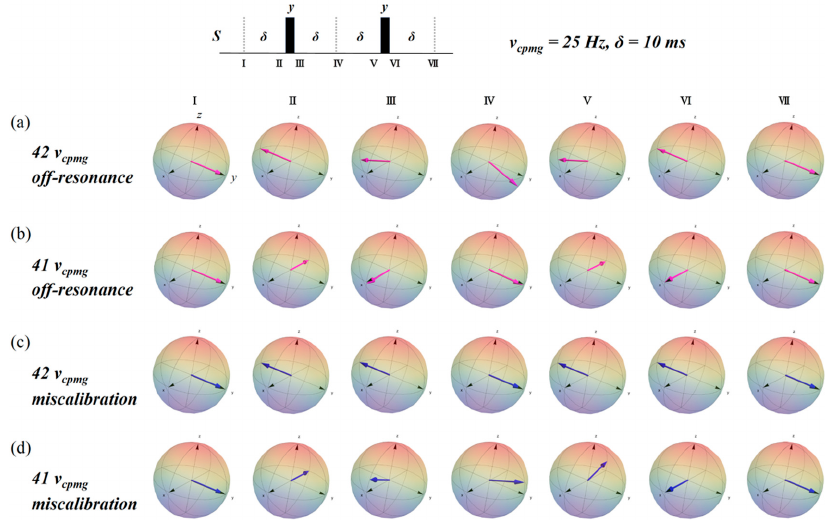
Figure 6. Magnetization vectors sampled at time points designated as ( I – VII ) in a simple CPMG pulse sequence, shown by a vector model in the rotating coordinate system. Two spin-echoes { δ – π y – δ } 2 were applied to the initial magnetization S y , which had no J coupling to any other spins. The period δ was set to 10 ms ( ν cpmg = 1/(4 δ ) = 25 Hz). The parameters used were almost the same as those in Figure 7. The refocusing π pulses were applied along the y -axis with a length of 80 µ s. ( a , b ) show simulation results involving off-resonance effects during the application of exactly calibrated pulses. The rf field strength was set to 6250 Hz. ( c , d ) show the results of simulation in which the refocusing π pulses were applied with the rf field strength reduced by 10% from the exact power with no off-resonance effects occurring during pulse application. The spin S frequency offsets were set to 42 * ν cpmg = 1050 Hz in ( a , c ) and to 41 * ν cpmg = 1025 Hz in ( b , d ). As shown in ( a , IV ), large deviations from the ideal orientation were found in the spin S vector at the frequency offsets of even multiples of ν cpmg . Such deviations occurred after an odd number of spin-echoes even if the pulse power was exactly calibrated. In contrast, pulse miscalibration caused large errors at the frequency offsets of odd multiples of ν cpmg after odd-numbered spin-echoes, as shown in ( d , IV